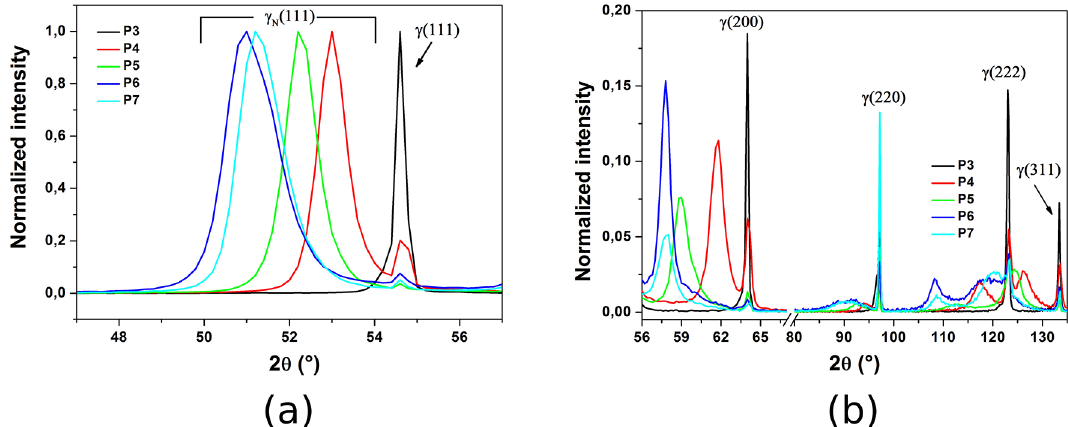
Figure 6. XRD patterns, at the θ-2θ geometry, using E=6.5 keV, of the reflections: (a) (111); (b) (200), (220), (222) and (311), for the samples nitrided at different pressures.